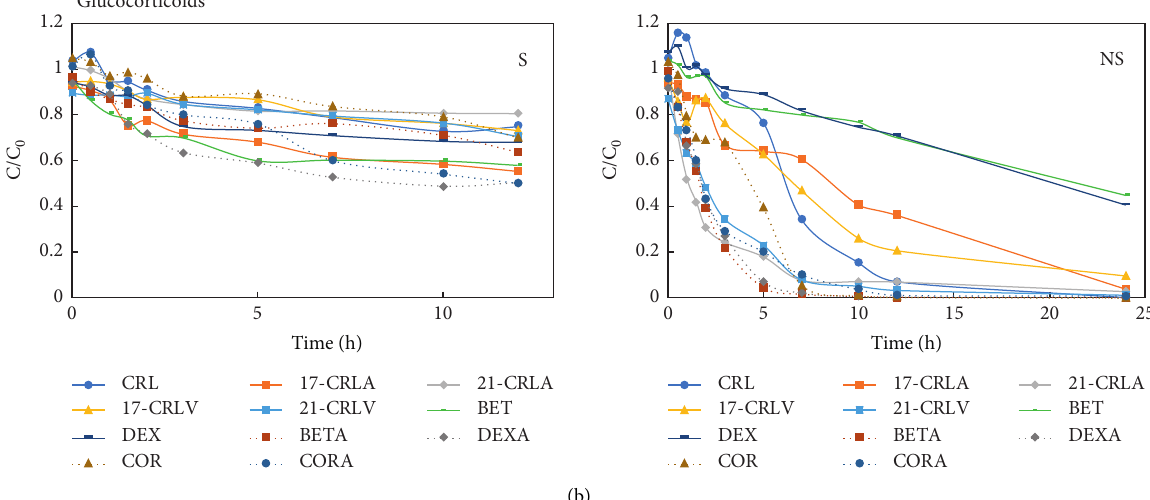
Figure 3: Degradation curves of steroids with 5% sludge concentrations. NS (nonsterile): slurry+ steroids and S (sterile): slurry+steroids+HgCl 2 . Table 2: Degradation parameters of the first-order kinetics model.